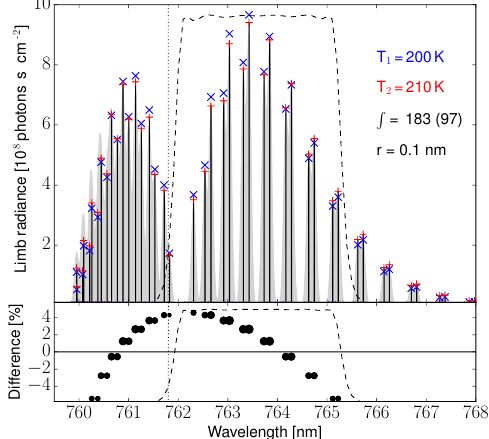
Figure 2. O 2 A-band limb emission line calculations assuming a global temperature of 200 and 210K (upper panel). The spectra in the upper panel have been normalized to show identical band inten- sities. The vertical bars and the blue signs mark the emission line in- tensities for 200K; the light gray area shows their intensities (mul- tiplied by a factor of 10) as seen from an instrument with a spec- tral resolution of 0.1nm. The red + signs show line intensities for 210K. The dashed line is the filter transmission curve of the instru- ment presented later. The dotted vertical line is drawn at the Littrow wavelength. Within the filter, more than 50% of the total band inten- sity (at 200K) are emitted (97 out of 183photonss − 1 cm − 2 sr − 1 ). The percentage difference of the line intensities at 200 and 210K is shown in the lower panel; the symbol size scales with the ab- solute intensity of the lines. The atmospheric background data are taken from the HAMMONIA model, and the spectroscopic data stem from the HITRAN database (Gordon et al.,